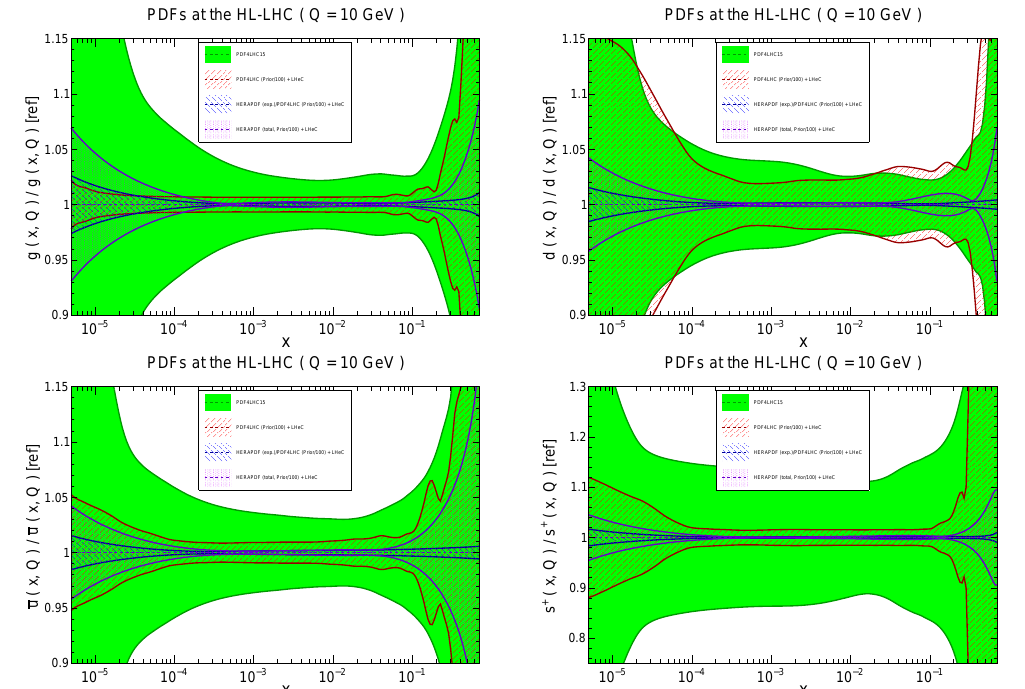
Figure 5.5: Impact of LHeC on the PDF uncertainties of the gluon, down quark, anti–up quark and strangeness distributions, with respect to the PDF4LHC15 and HERAPDF baselines, when the relative impact of the initial PDF prior, that is, of the datasets included in the baseline PDF sets, is reduced by a factor of 100. For the HERAPDF case we show results corresponding to the experimental uncertainties only baseline and that including model and parameterisation uncertainties. A tolerance of T = 1 is taken in all profiled cases, while the result of the PDF4LHC set (including prior but with no LHeC data) is shown for